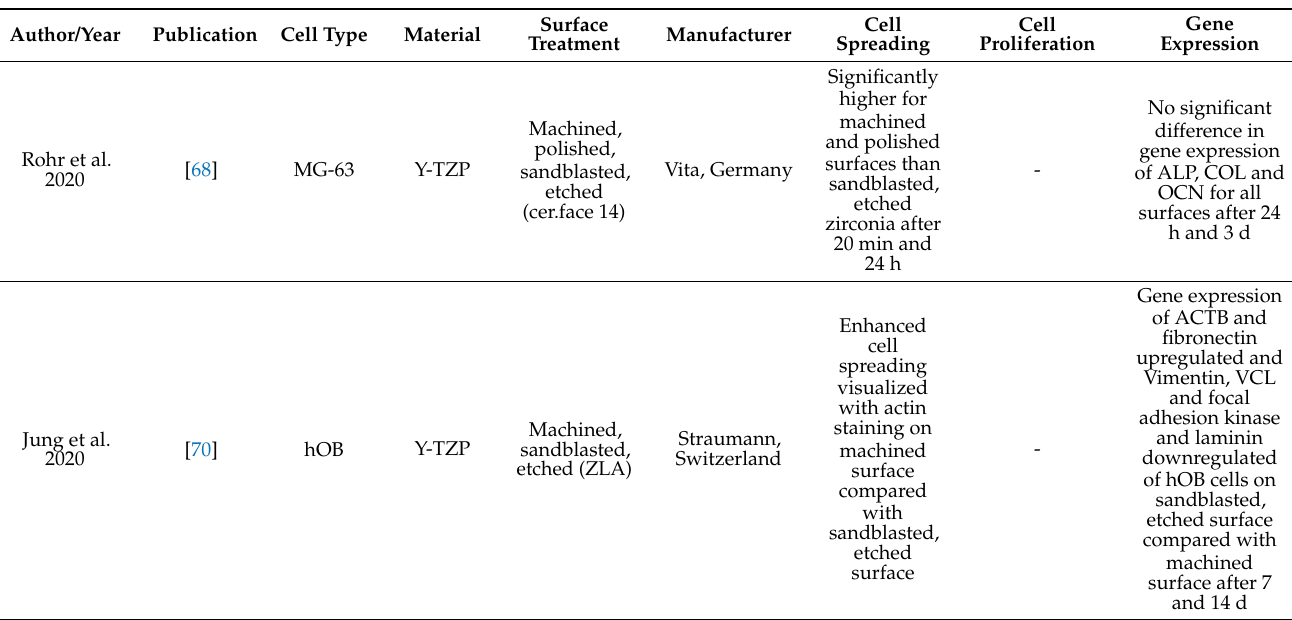
Table 3. Overview of cell studies with osteoblast that compared two different zirconia implant surfaces by measuring cell spreading, cell proliferation or gene expression.